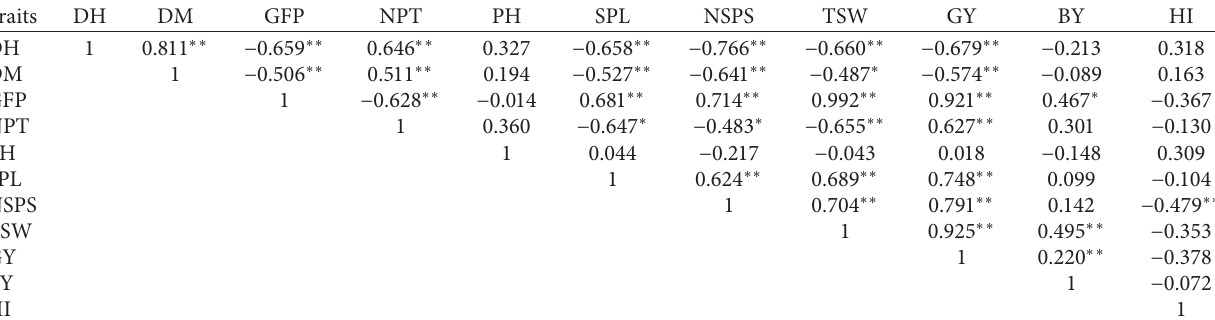
Table 3: Genotypic correlation coefficients of the eleven bread wheat traits. Traits